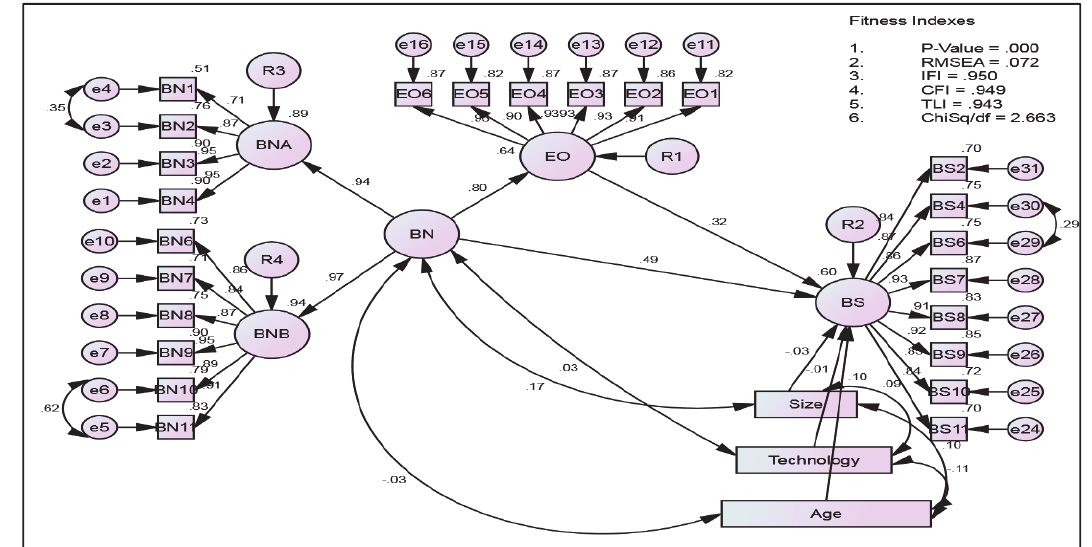
Fig. 4. SEM analysis with control included